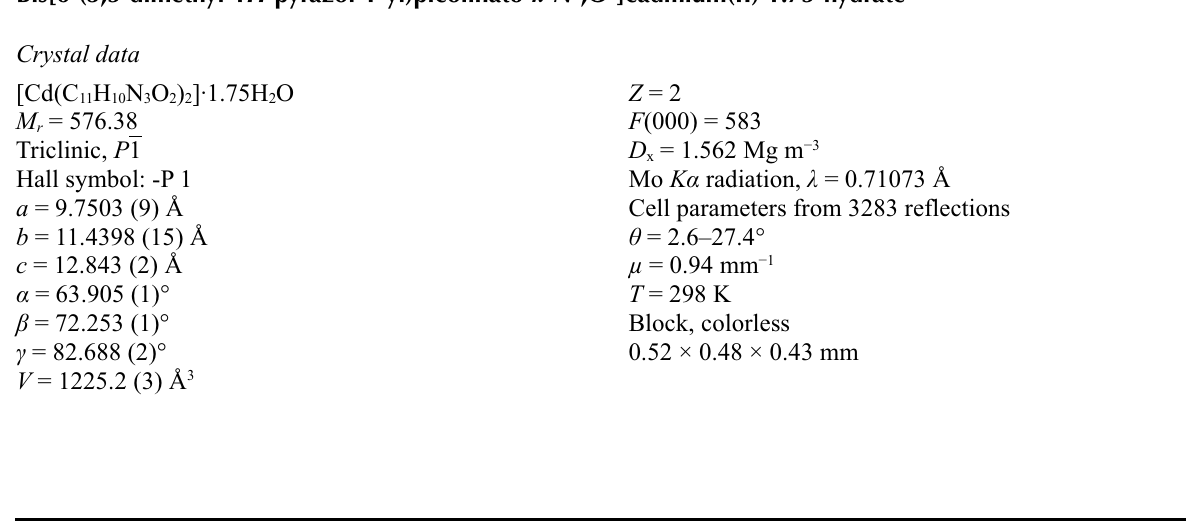
Crystal packing in (I) showing the hydrogen bonding interactions as dashed lines. Bis[6-(3,5-dimethyl-1 H -pyrazol-1-yl)picolinato- κ 2 N 1 , O 2 ]cadmium(II)